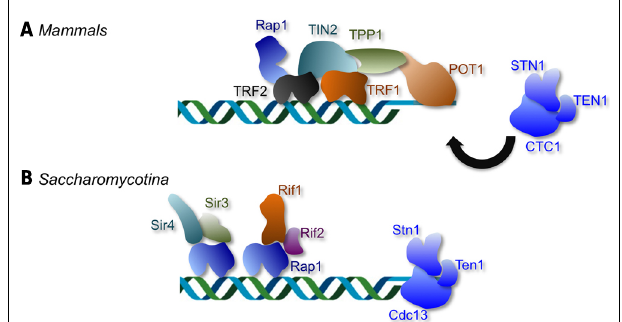
FIGURE 1 | The distinctive telomere protective complexes in mammals and in Saccharomycotina yeast. (A) The mammalian telomeres are bound by a six-protein complex collectively named shelterin. Within the telomere nucleoprotein complex, duplex telomeres are bound directly by TRF1 and TRF2, and G-tails are bound directly by POT1. The mammalian CST (CTC1-STN1-TEN1) complex plays minimal roles in telomere protection, but is crucial for regulating telomere DNA synthesis. (B) The telomere complexes of Saccharomycotina yeast display considerable differences from those in other phyla; the duplex telomeres and G-tails in Saccharomycotina yeast are bound by Rap1 and Cdc13, respectively. Like CTC1, the fungal Cdc13 is part of the CST complex that also contains Stn1 and Ten1. However, unlike mammalian CST, the fungal CST complex is crucial both for telomere protection and for regulating telomere DNA